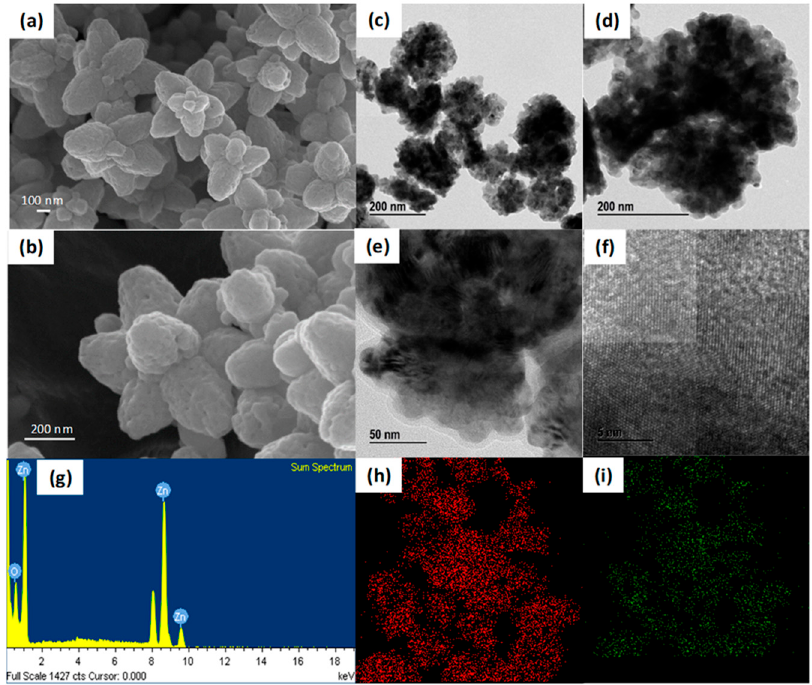
Figure 2. FE-SEM ( a , b ) and TEM images of LC-ZnO/OF ( c – f ). EDS and elemental analysis of LC- ZnO/OF ( g – i